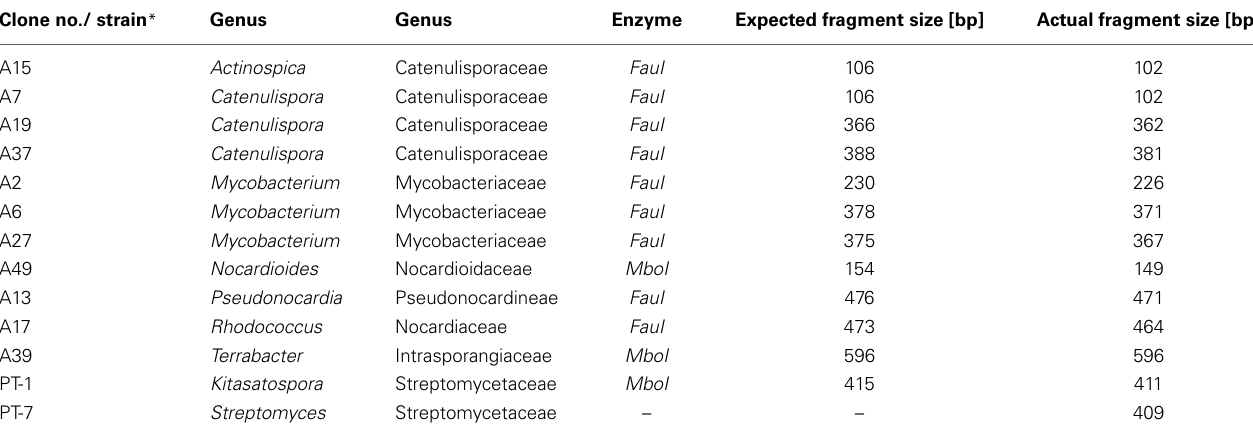
Table 2 | T-RF sizes of the amplicons of 16S rRNA gene fragments from clones and pure cultures after double digest ( MboI/FauI ). Clone no./ strain *